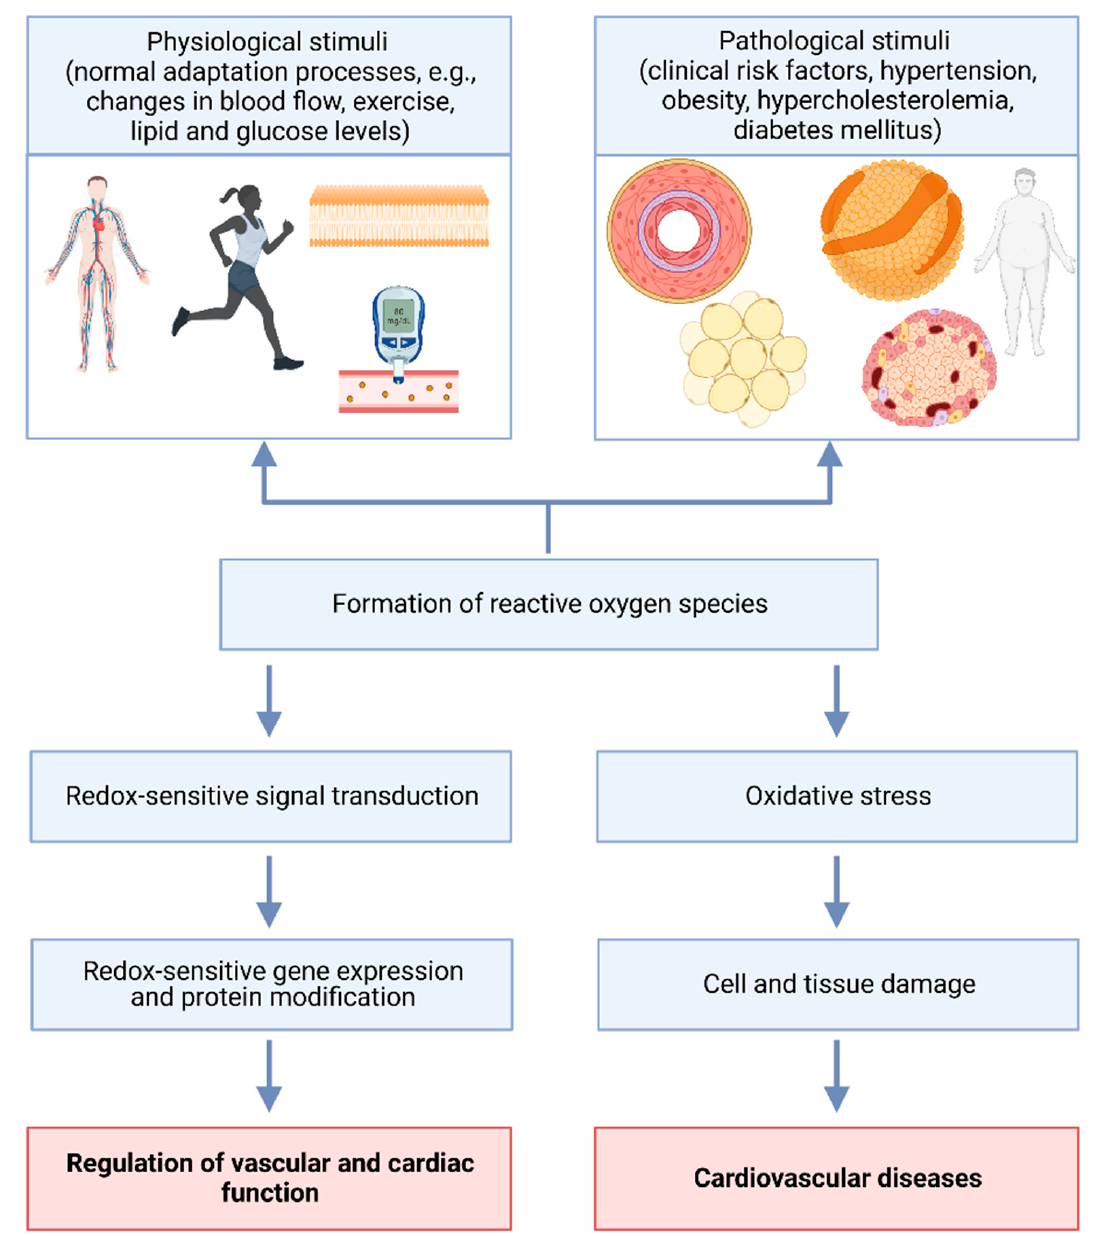
Figure 1. Impact of physiological and pathophysiological stimuli on the regulation of vascular and cardiac function and cardiovascular diseases. Physiological stimuli like exercise can induce redox-sensitive signal transduction and the regulation of vascular and cardiac function. Redox-sensitive signal transduction, gene and protein expression and the regulation of vascular and cardiac function are also present in patients with cardiovascular diseases, despite being altered. Clinical risk factors and the metabolic syndrome can increase levels of vasoactive substances like angiotensin II, oxidative stress, cell and tissue damage, as well as in long-term cardiovascular diseases. Created with BioRender.com.